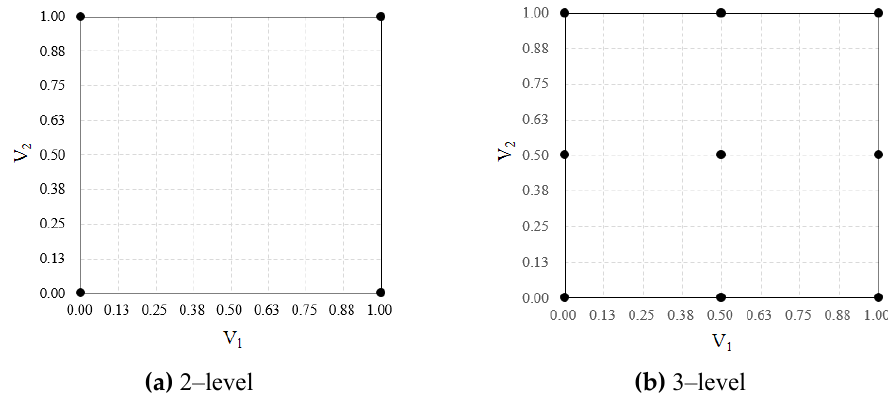
Figure 5. Examples of the full factorial designs.